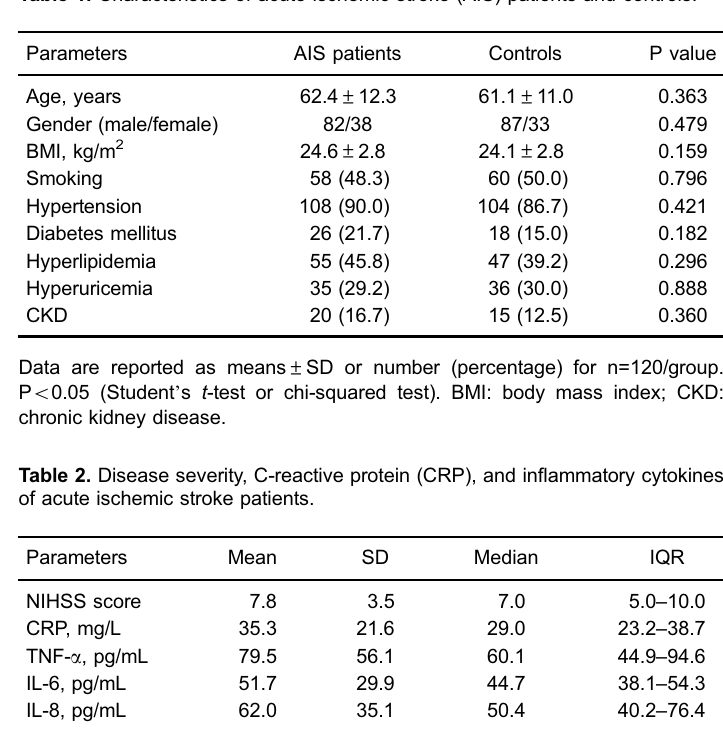
Table 1. Characteristics of acute ischemic stroke (AIS) patients and controls.